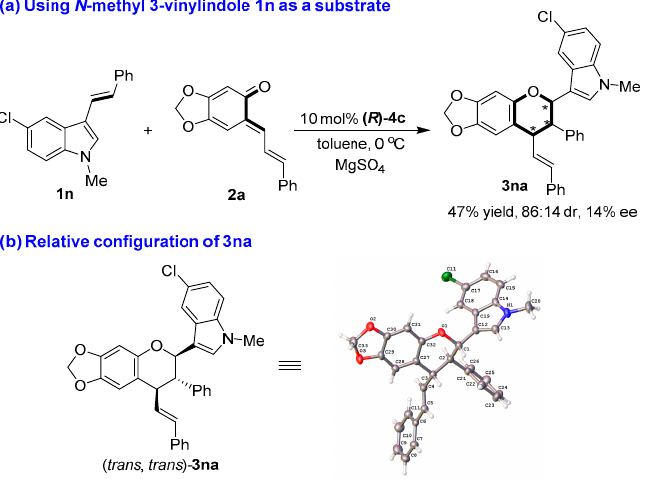
Figure 5. Determination of the relative configuration of 3na . The asterisk * indicates chiral center.